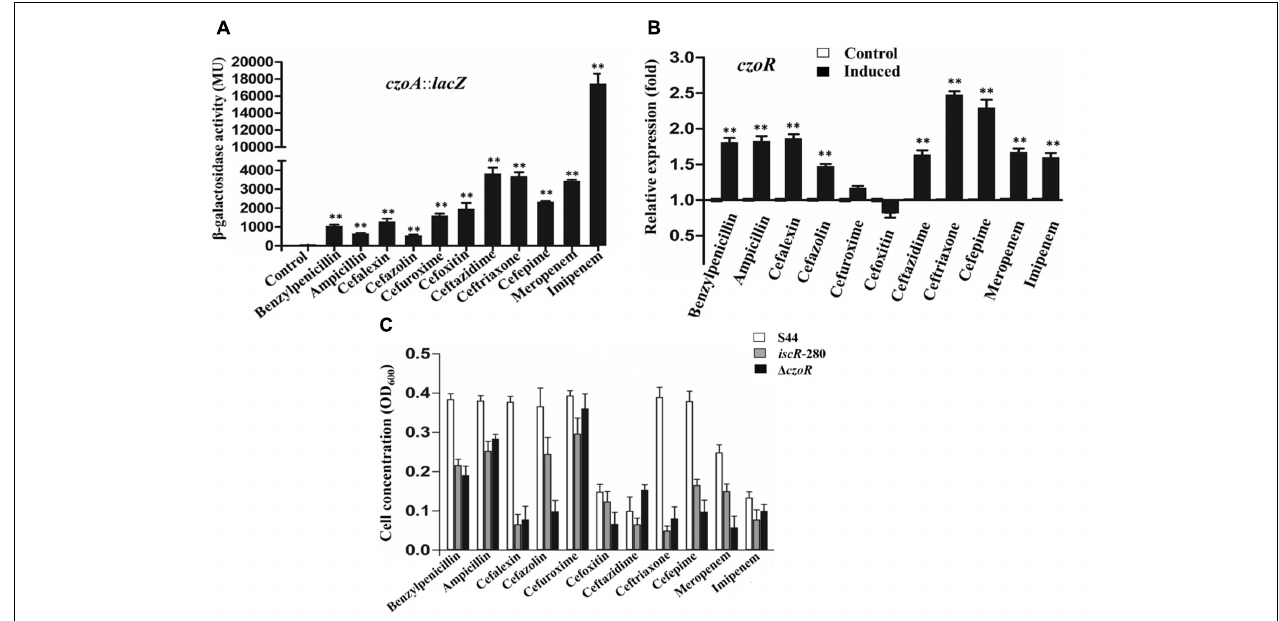
FIGURE 2 | czoA and czoR were induced by different β -lactams. (A) A lacZ reporter fusion of czoA . Bacteria were cultured in LB medium with addition of 25 µ g/ml benzylpenicillin, ampicillin, cephalexin, cefazolin, cefuroxime, cefoxitin, ceftazidime, ceftriaxone, cefepime, and 0.5 µ g/ml meropenem and imipenem. A culture without β -lactams was used as a control. (B) Real-time RT-PCR results for czoR in S44. The relative czoR mRNA expression levels induced by 11 β -lactams (black bars) and in the control (without induction, white bars) were determined as described in the Section “Materials and Methods.” Error bars represent standard deviations of triplicate tests. The selected induction concentrations, which did not affect normal growth, were well below the MIC for the β -lactams. ∗∗ Indicates a significant difference from the control ( p < 0.01, Student’s t -test). (C) The growth tendency of the isogenic strains of S44 under the stress of the 11 β -lactams